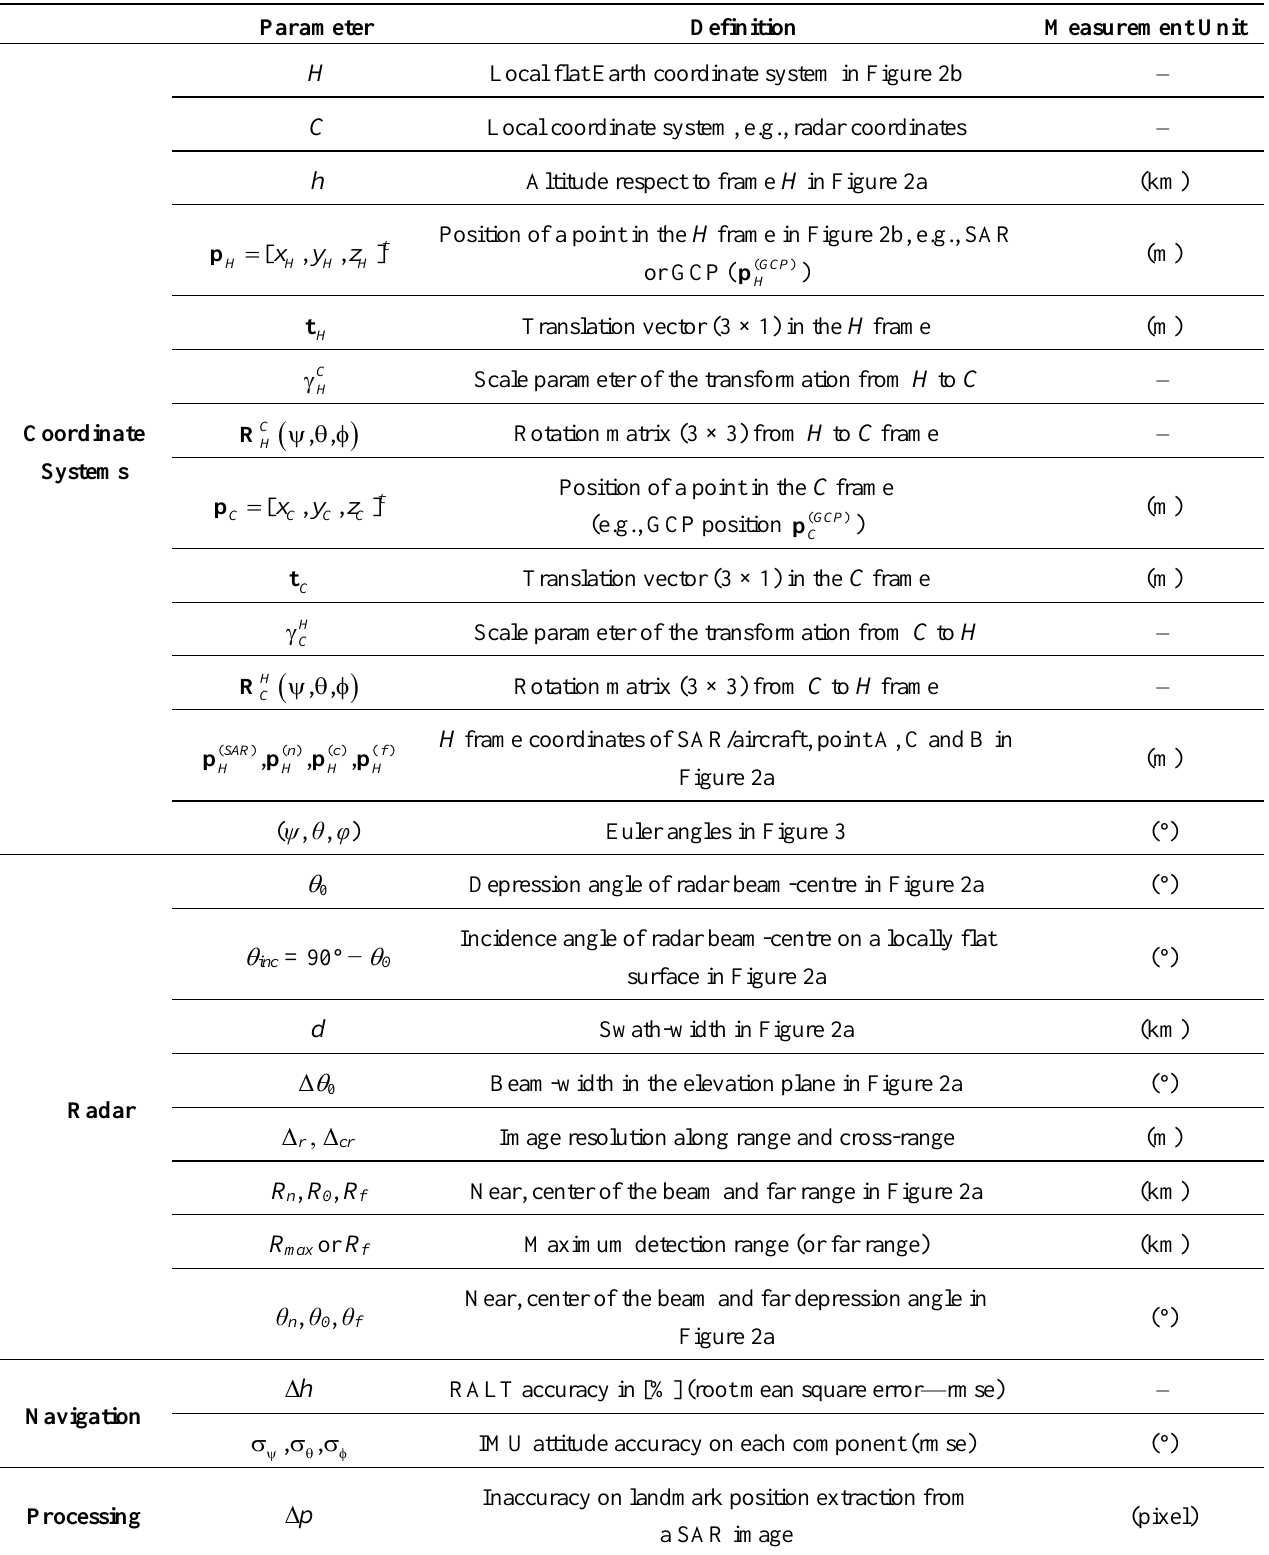
Table 1. Parameter classification, definition and measurement